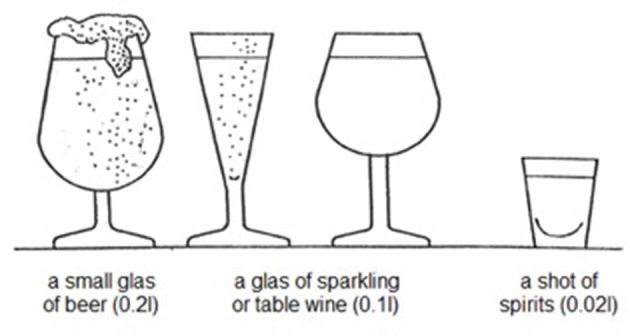
Amounts of different alcoholic beverages that correspond to 1 standard drink as defined by the World Health Organization. This illustration has been shown to the participants of this study to guide them in estimating their individual average alcohol intake per drinking occasion.